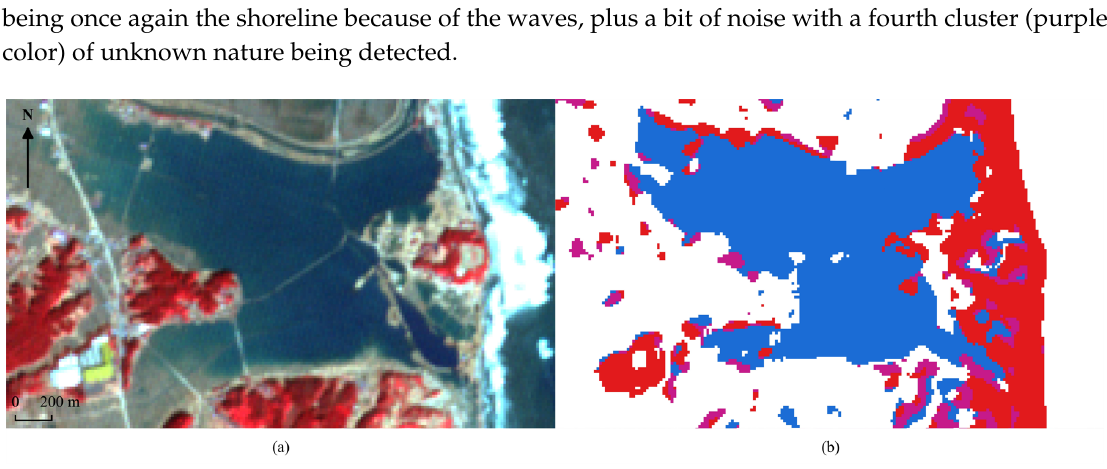
Figure 11. ( a ) Extract of the original post-disaster image ( b ) Clustering results with 4 clusters from the DEC algorithm. On the left is the post-disaster image, on the right the clustering applied within a 5 km distance from the shore. We have the following clusters: (1) In white, no change. (2) In blue, flooded areas. (3) In red, damaged constructions. (4) In purple, other